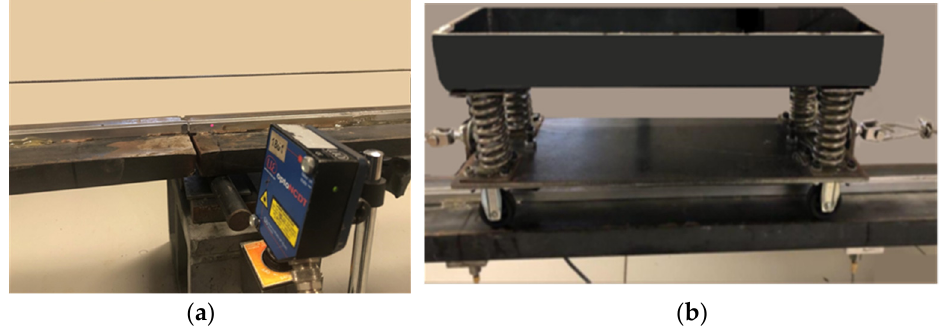
Figure 12. ( a ) Details at the left-hand support of the main beam, ( b ) the two-axle model vehicle. The model vehicle (Figure 12b) had two axles spacing at 30 cm and running on four